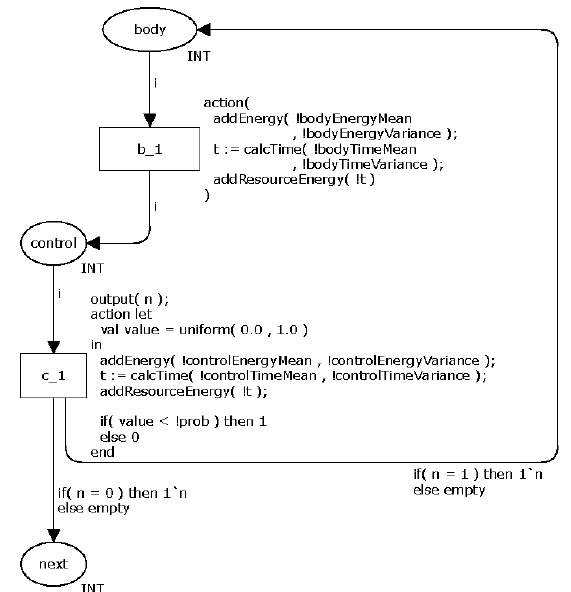
Figure 6. CPN model of the command do-while